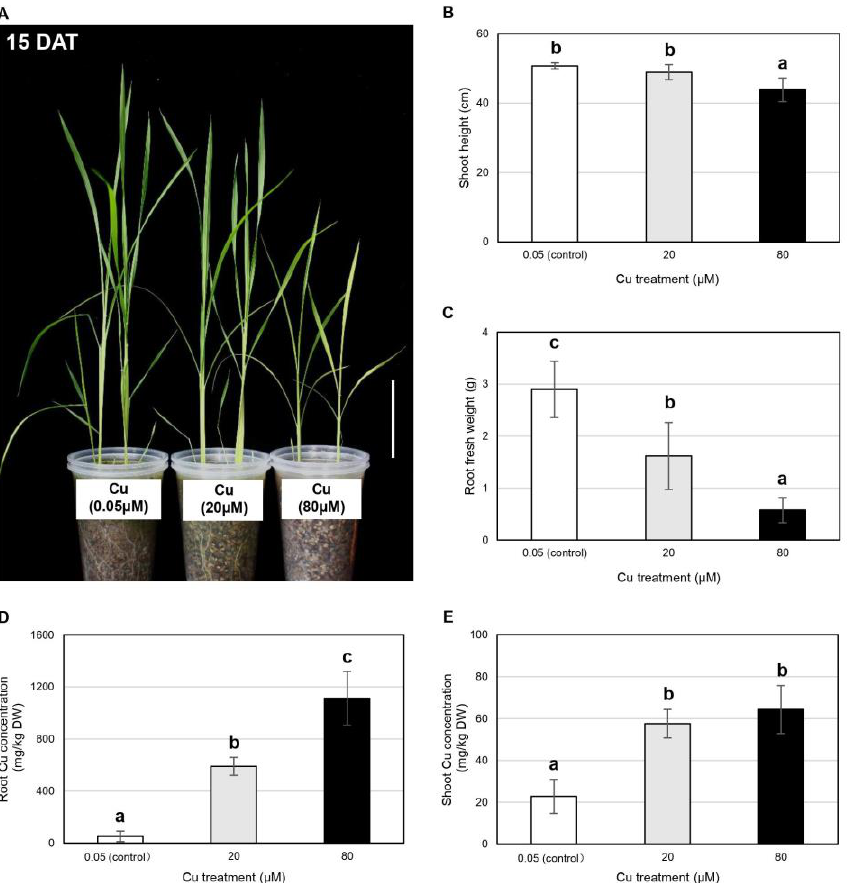
Figure 2. Effect of 20 and 80 µM Cu on the physiology of vegetative rice plants at 15 DAT: ( A ) Shoot morphology (scale bar = 10 cm); ( B ) shoot height; ( C ) root fresh weight (FW); ( D ) root Cu concentration (mg/Kg DW) and ( E ) shoot Cu concentration (mg/Kg DW) are shown. Data are means ± SD (shoot height, n = 10; root FW, n = 4; tissue Cu concentrations, n = 4). One-way ANOVA and Tukey’s post hoc test were used for each measurement, with different letters denoting a significant difference ( p <